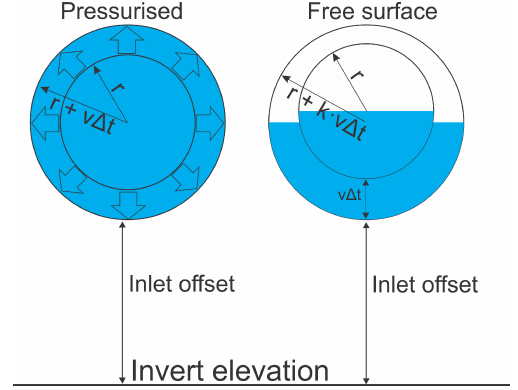
Figure 5. Growth of a conduit with pressurized flow and a con- duit with free-surface flow. r is radius, k is the fraction of wetted perimeter, v incision (growth)